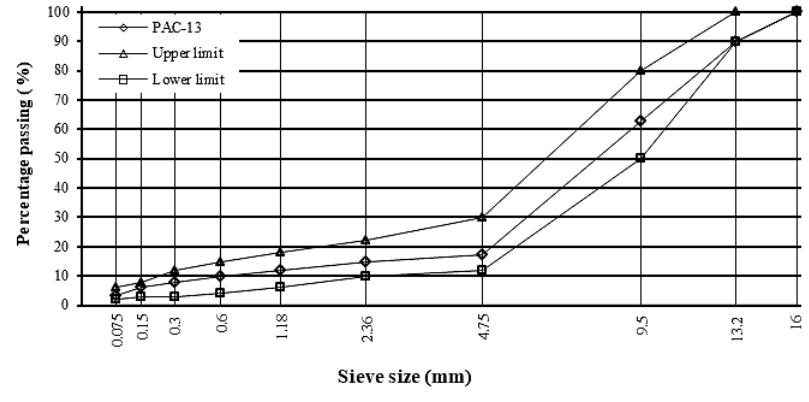
Figure 1. Aggregate gradation of PAC-13 mixture.